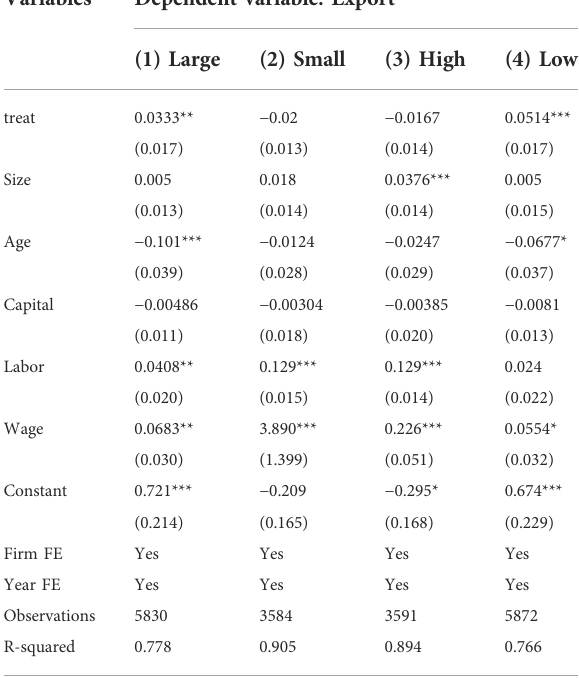
TABLE 6 Heterogeneous results of scale and industrial